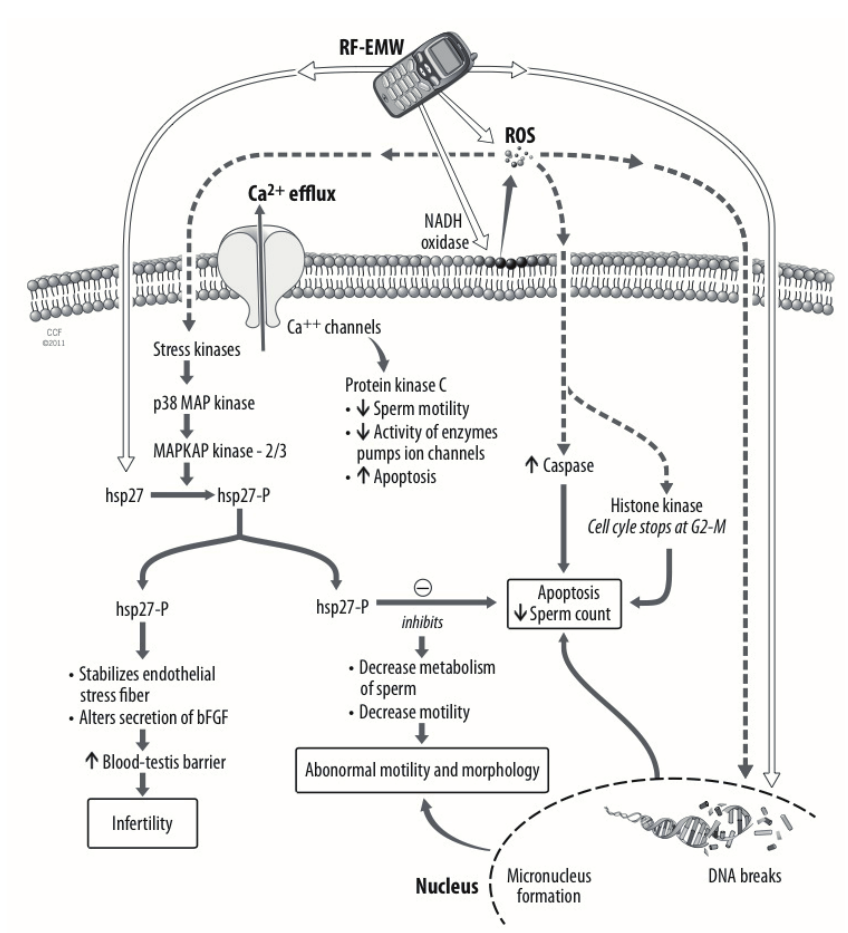
Figure 5 - Effects of RF-EMW on cellular